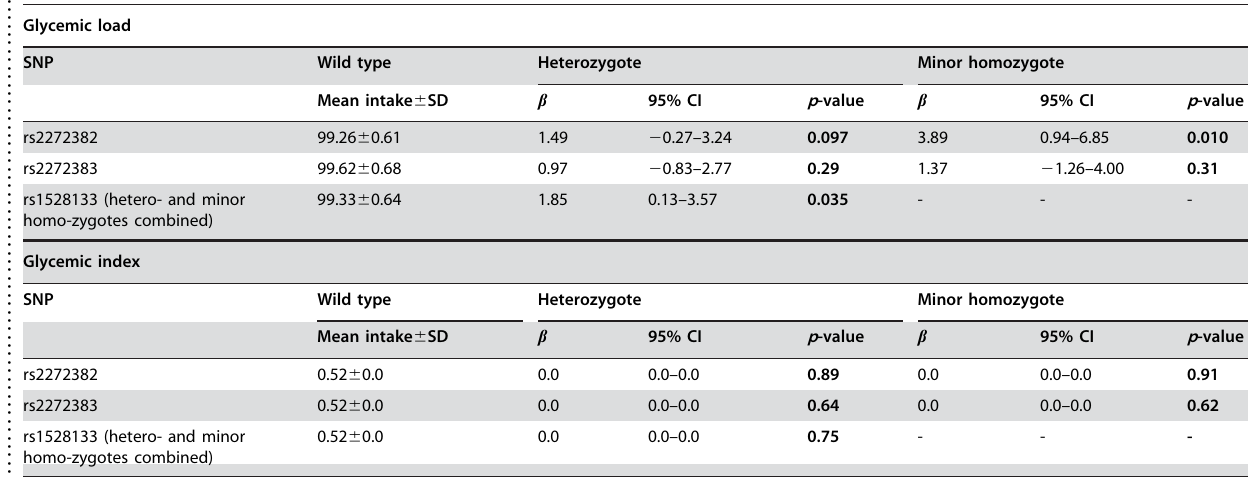
Table 4. Association of glycemic load (GL) and glycemic index (GI) with the single nucleotide polymorphisms in the TUB gene. .. ... .... ... ... .... ... ... .... ... ... .... ... ... .... ... ... .... ... ... .... ... ... .... ... ... .... ... ... .... ... ... .... ... ... .... ... ... .... ... ... .... ... ... . Glycemic load